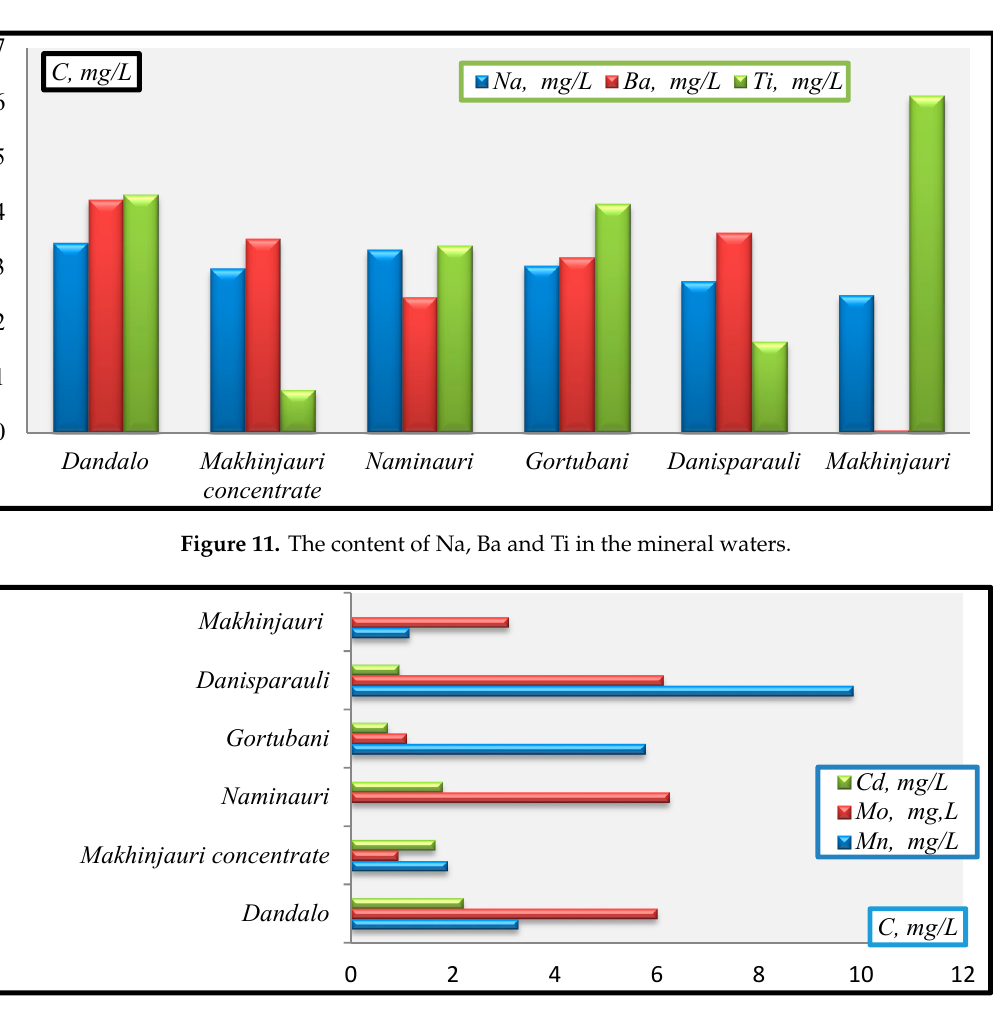
Figure 12. The content of Cd, Mo and Mn in the mineral waters.